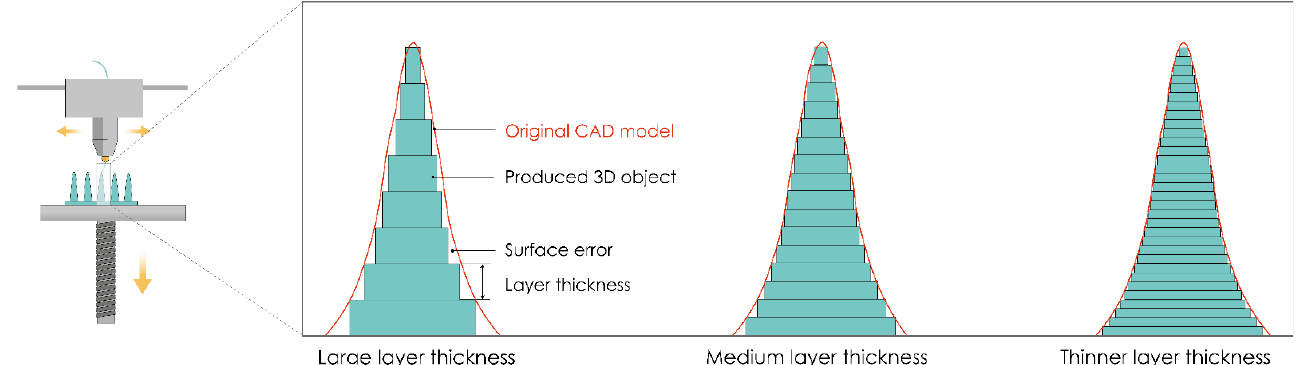
Figure 7. The staircase phenomenon for different layer thicknesses. The image was created with Adobe Illustrator CC (Version 23.0.1.; Adobe Inc., San Jose, CA, USA, 2019).